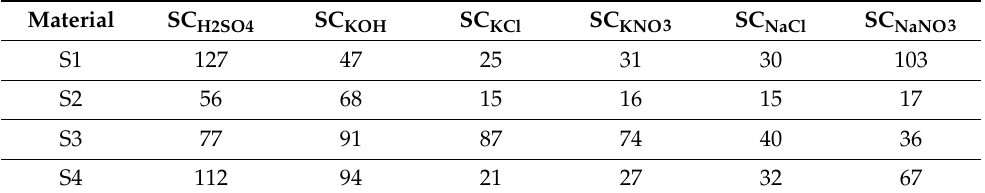
Table 4. Specific capacitance values (F/g) achieved for all soy-based carbon materials in 1 M H 2 SO 4 and 6 M